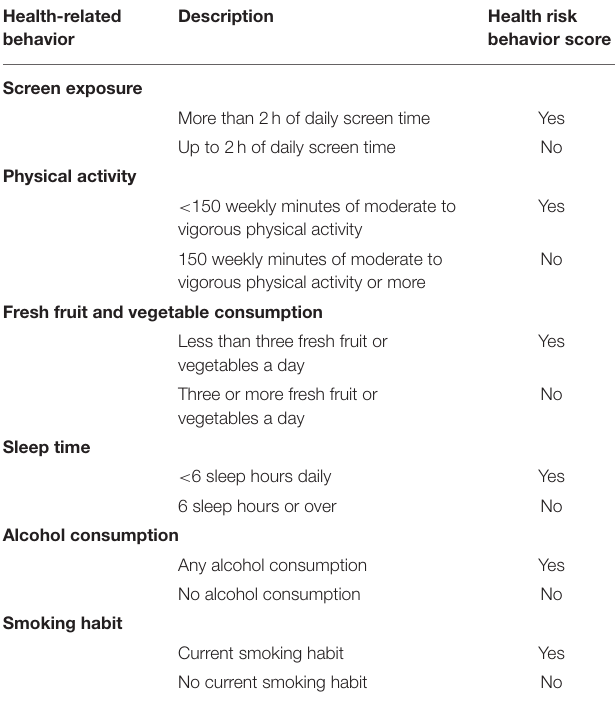
TABLE 1 | Description of each of the health-risk behaviors included in the